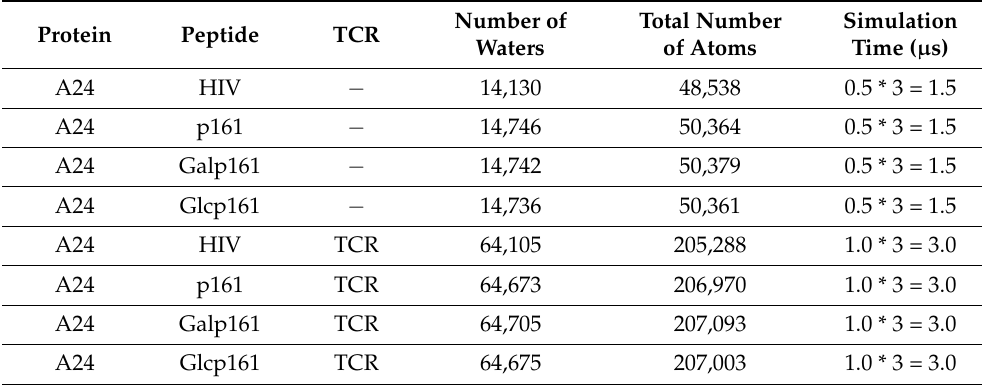
Table 2. The A24-peptide complexes in the presence and absence of both kinds of glycosylation and TCR subjected to MD simulations (in